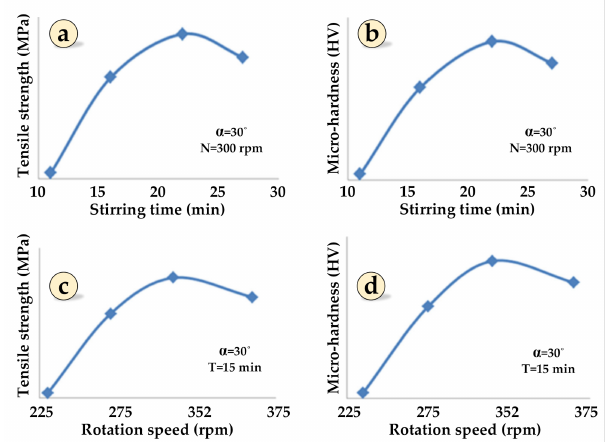
Figure 6. Tensile ( a , c ) and hardness ( b , d ) values of TiC/AA6061 composites. α is blade angle, T stirring time, and N stirring speed reproduced from [37], with permisssion of Springer,